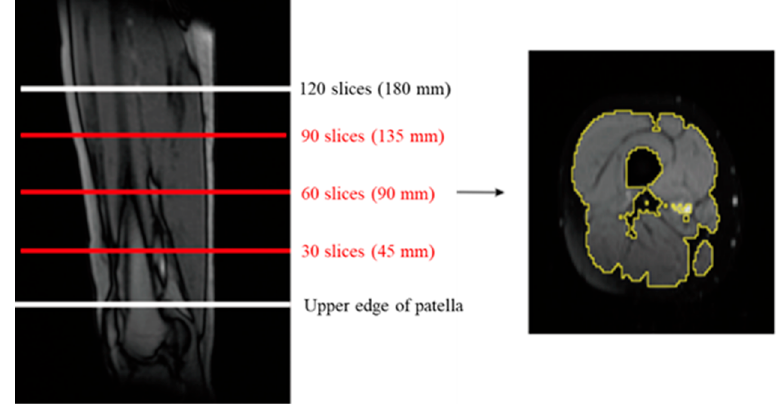
Figure 2. Cross-sectional muscle area of the thigh for segmentation and a sample segmented image.